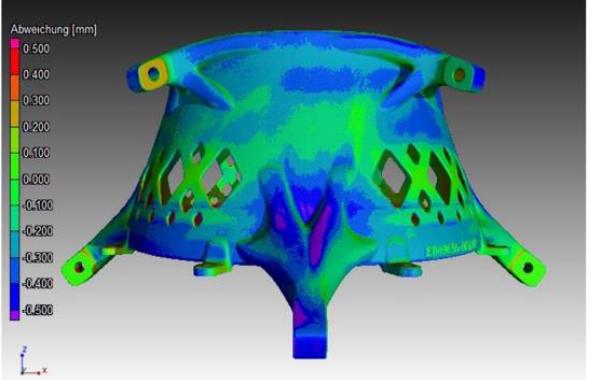
Figure 22. Actual versus nominal comparison of the hub from the CT data.